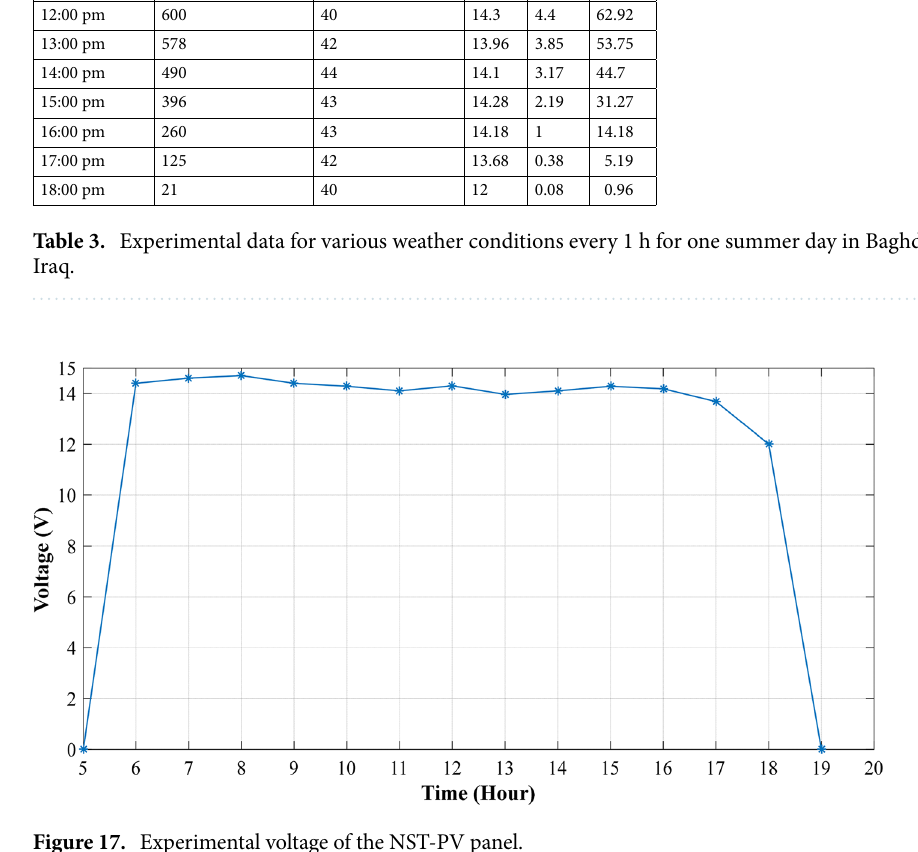
Figure 17. Experimental voltage of the NST-PV